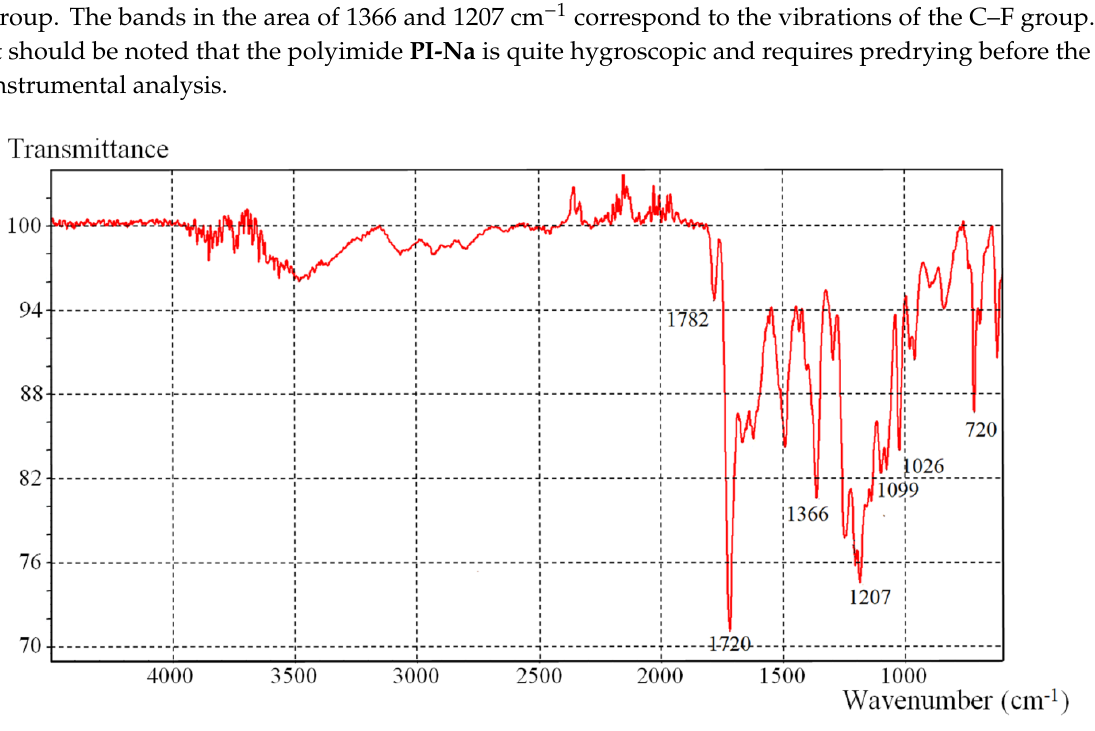
Figure 1. Infrared (IR) spectra of PI-Na .